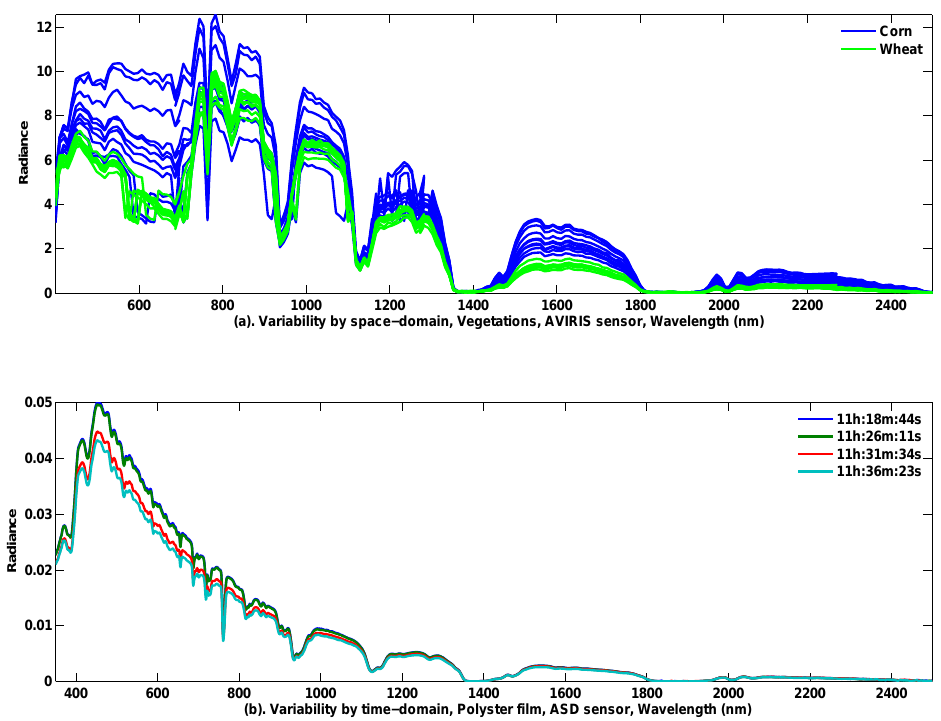
Figure 2. Variability of the spectral